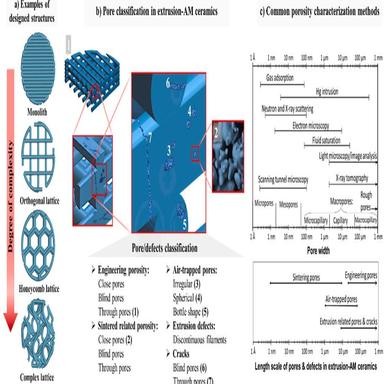
Types of porosity in robocast ceramics. a) Monoliths (100% of infill) and 3D lattices with different pore morphology and size can be engineered in silico. b) Pore classification in robocast ceramics. C) Detection ranges of the most common techniques for the evaluation of porosity (top; adapted from ) and length-scale of the different pore types in robocast ceramics (bottom), pore size is indicated according to the IUPAC classification.